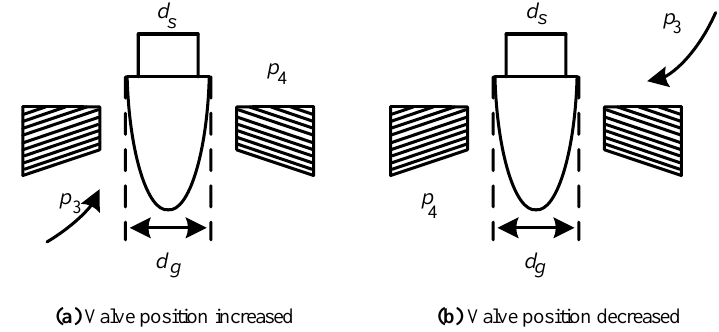
Figure 4. Structure diagram of straight-through single-seat valve